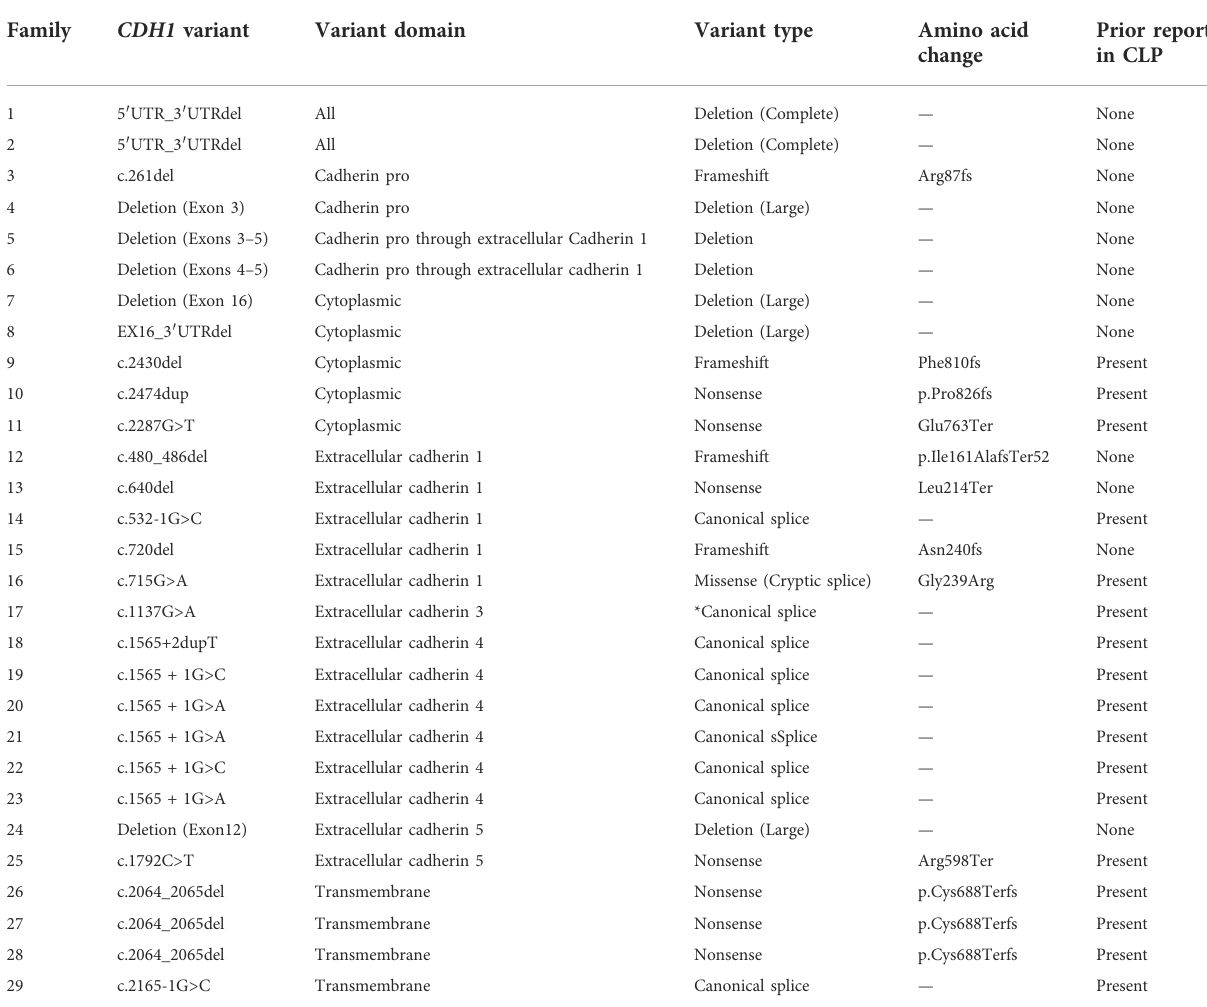
TABLE 2 CDH1 variant genotype for each family with